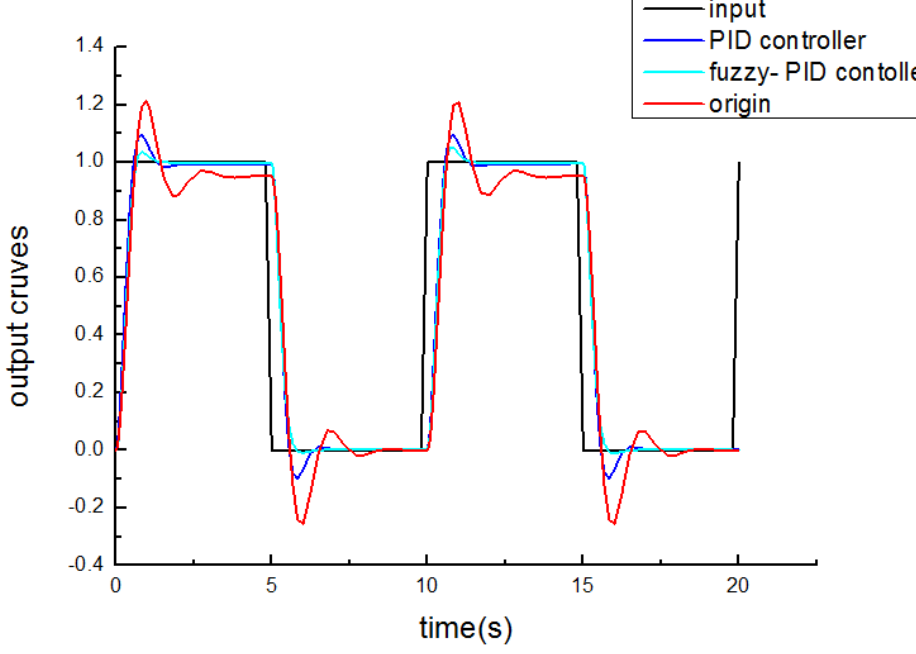
Figure 8. Response curves of different control methods. Increased an added interference signal by 0.5 after 5 s in each period, the simulation curves are showed in Figure 9. It can be seen that the conventional PID control has nearly no anti-interference ability, while the Fuzzy-PID control is characterized by small fluctuations and a strong anti-interference